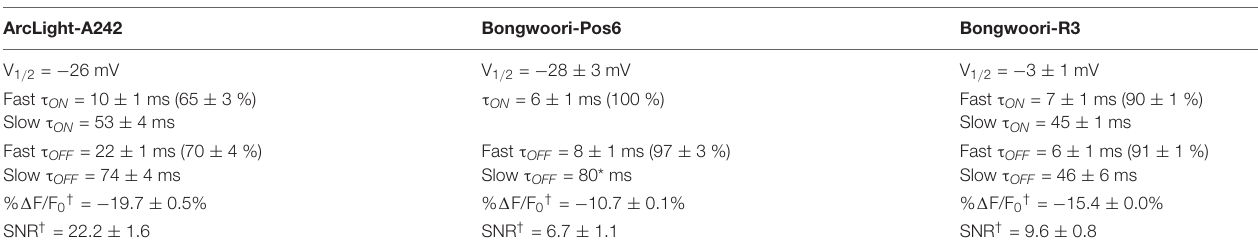
TABLE 1 | Characteristics of the GEVIs used in this